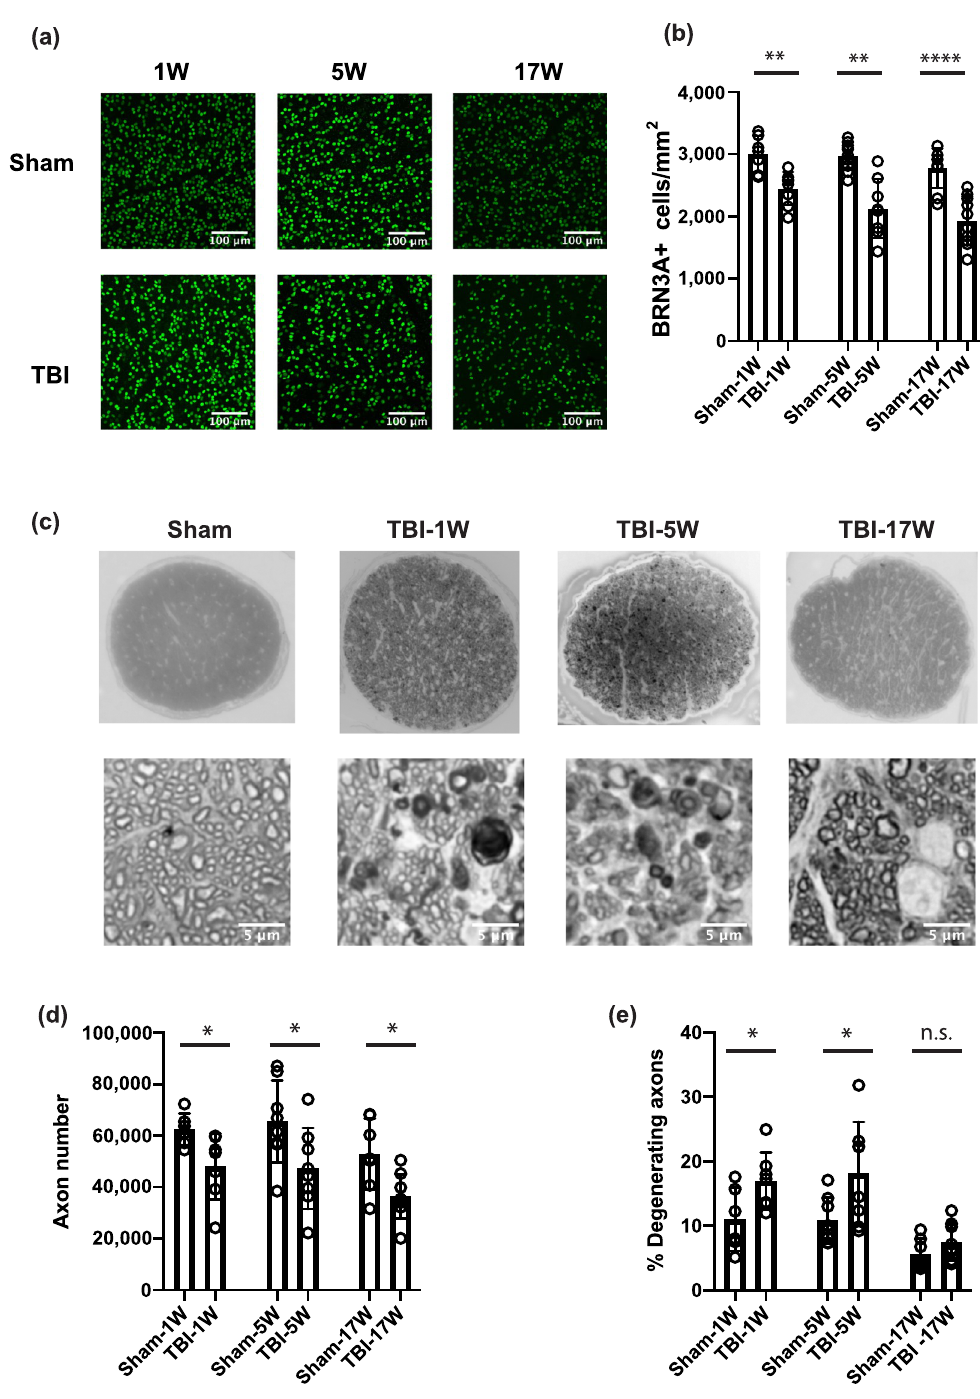
Figure 1. Blast-mediated traumatic brain injury (bTBI) was associated with loss of BRN3A + retinal ganglion cells (RGCs) and axons. ( a ) Representative images from the mid-central area of whole-mount retinas stained with anti-BRN3A antibody (green) at the indicated time-point. Mice were sham treated or subjected to bTBI. ( b ) Quantification of BRN3A + RGCs at 1 week (1 W), 5 weeks (5 W) and 17 weeks (17 W) after injury. ( c ) Representative images of paraphenylenediamine (PPD)-stained optic nerves from sham mice and bTBI mice at 1 W, 5 W, and 17 W after injury, at low (upper row) and high (lower row) magnification. ( d ) Quantification of axons in PPD-stained optic nerves at 1 W, 5 W, and 17 W after injury. The optic nerves examined were from the retinas in which the BRN3A + cells were quantified. ( e ) Percent of degenerating axons in PPD-stained optic nerves at 1 W, 5 W and 17 W after injury. Bars represent mean ± SD and each data point represents a biological sample; unpaired two tailed t -test with Welch’s correction: * p < 0.05, ** p < 0.01, **** p < 0.0001, n.s. not significant. The images were processed in Fiji 111 , the graphs were generated in Prism 8 software and the figure was assembled in Adobe Illustrator CC